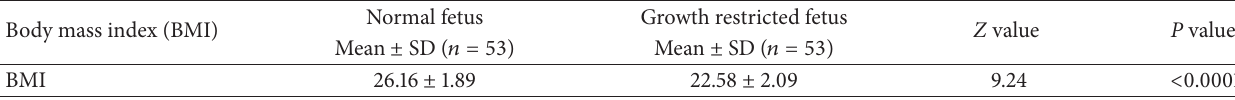
Table 4: The comparison of body mass index (BMI) in study groups.